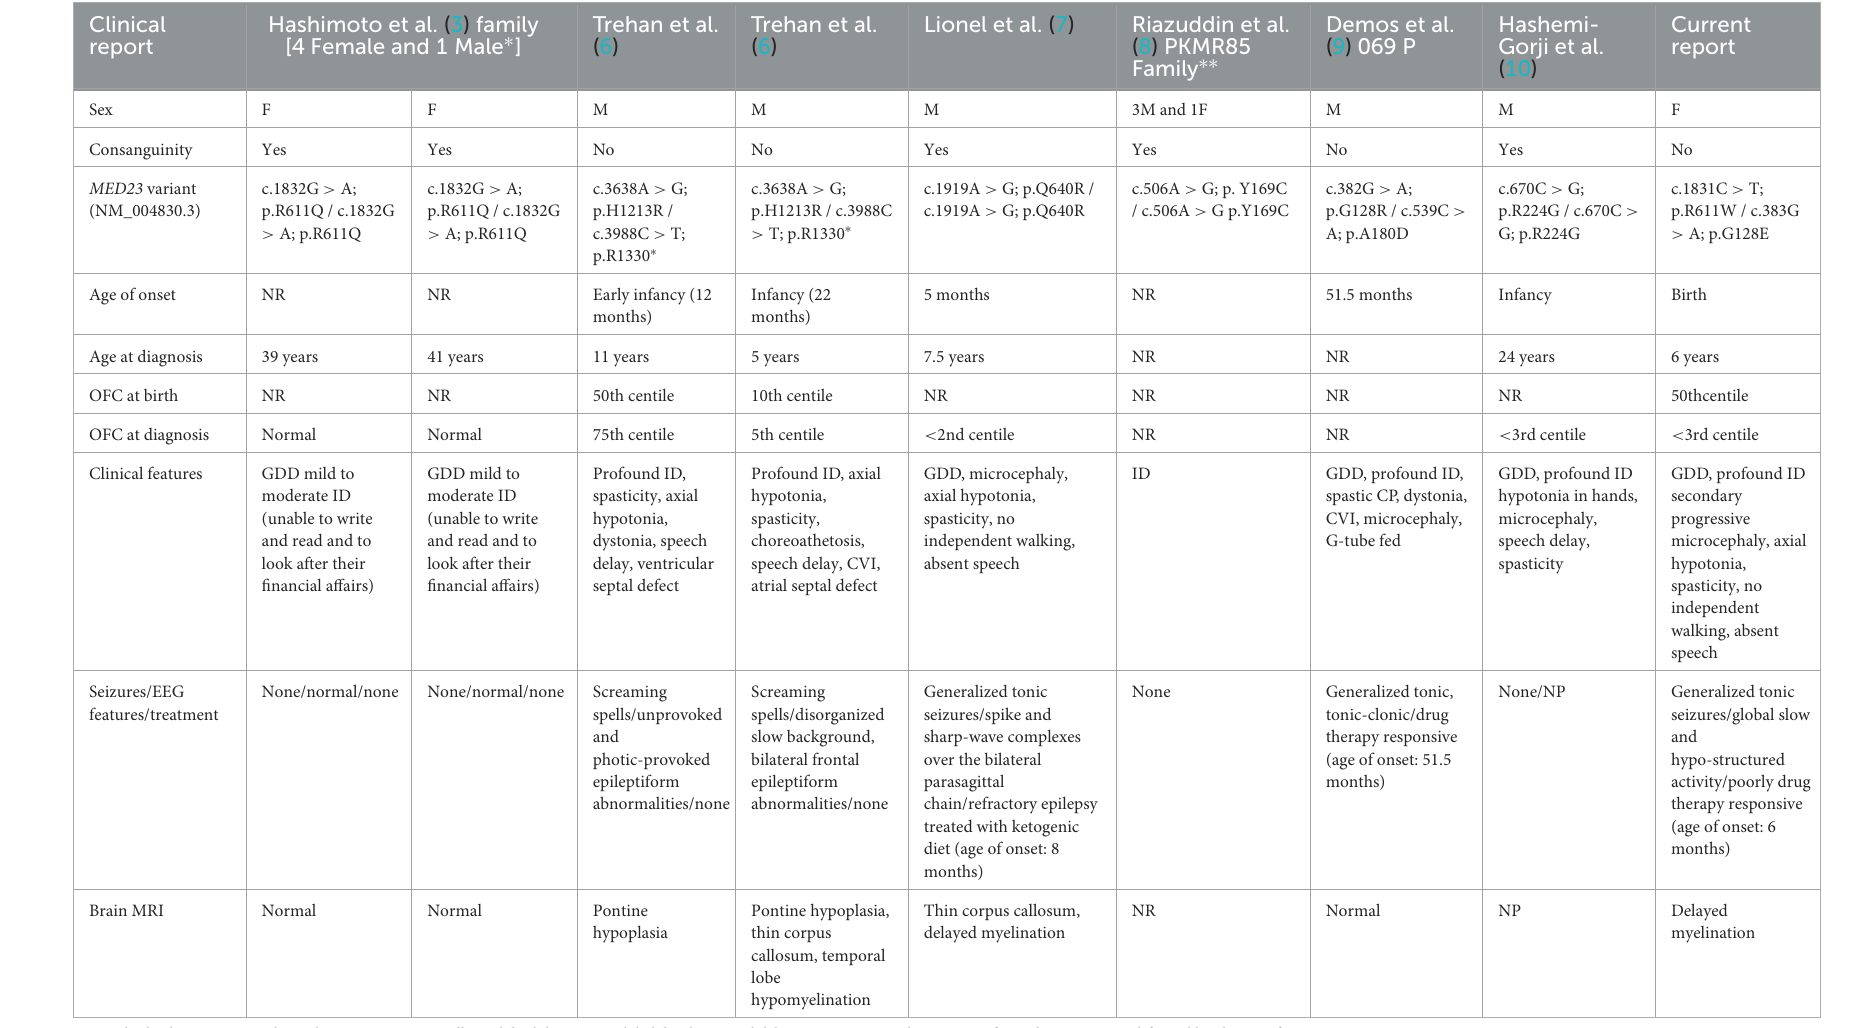
TABLE 1 Summary of subjects and our case with MED23 -associated disorder. Clinical